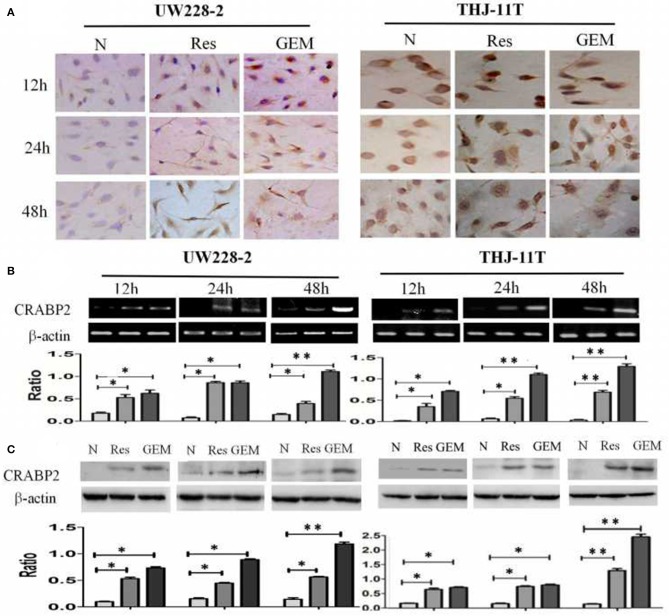
Demonstration of upregulated CRABP2 expression in 100 μM resveratrol (Res) or 10 μM gemcitabine (GEM)-treated THJ-11T and UW228-2 cells. (A) Immunocytochemical staining (×40); (B) RT-PCR; (C) Western blotting. β-actin was used as qualitative and quantitative control. N, cultured in 0.2% dimethylsulfoxide (DMSO)-containing medium; Res, 100 μM resveratrol; GEM, 10 μM gemcitabine. Ratio, the ratio between the levels of the target molecules and that of β-actin; NS, no statistical significance (p > 0.05); *with statistical significance (p < 0.01; **p < 0.001) the error bars, the mean ± standard deviation.